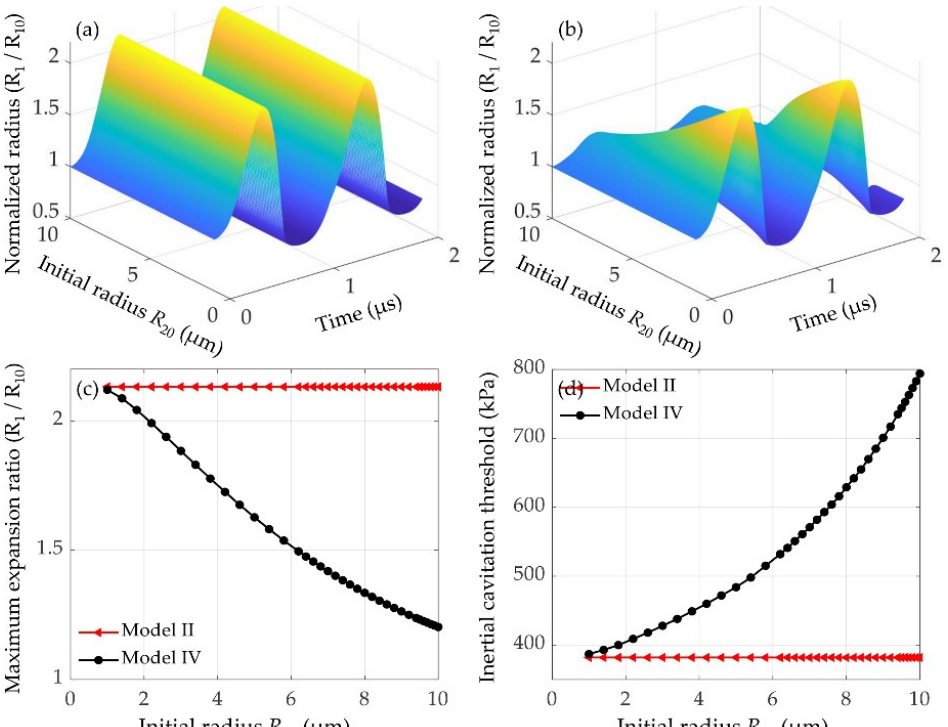
Figure 8. Dynamics and inertial cavitation threshold of a 1 µ m lipid-coated bubble with the presence of a nearby microbubble having different initial radii ( R 20 = 1–10 µ m) at p A = 400 kPa and d i,j = 20 µ m, including the bubble dynamics as a function of time ( a ) without (model II) and ( b ) with (model IV) considering the bubble–bubble interactions, ( c ) the maxima of the normalized radii and ( d ) the inertial cavitation threshold as function of the initial radius of the nearby microbubble R 20 . The effects of medium viscoelasticity on the bubble dynamics and inertial cavitation threshold are examined as shown in Figure 9. Examples of the maximum expansion ra- tio of a 1 µ m lipid-coated microbubble without and with considering the bubble − bubble interactions at different medium elasticities (10~500 kPa) and viscosities (1~30 mPa · s) are shown in Figure 9a,b, respectively. Corresponding, the inertial cavitation thresholds of the microbubbles at different medium viscoelasticity are shown in Figure 9d,e, respectively. It showed similar variation tendencies in both cases, i.e., increasing the medium elasticity and viscosity, the bubble oscillations are noticeably suppressed, and in turn the inertial cavitation threshold increases, which agree well with the previous work [28,34,41,42,55,57]. Compar- ing the results obtained without and with considering the bubble − bubble interactions, it demonstrates that the difference of the maximum expansion ratios between the isolated and affected microbubbles becomes smaller (Figure 9c), but the difference of inertial cavi- tation threshold becomes larger (Figure 9f), with the medium viscosity and/or elasticity increasing. It indicates that increasing the medium viscoelasticity would suppress the oscillations of microbubble, which in turn reduce the bubble − bubble interactions, exactly as described in previous studies [55,57]. However, the increase in the medium viscoelastic- ity can also distinctly suppress the bubble oscillations, and result in the onset of inertial cavitation requiring higher acoustic pressure threshold, even if the suppression effect of the bubble − bubble interactions on the bubble oscillations has been